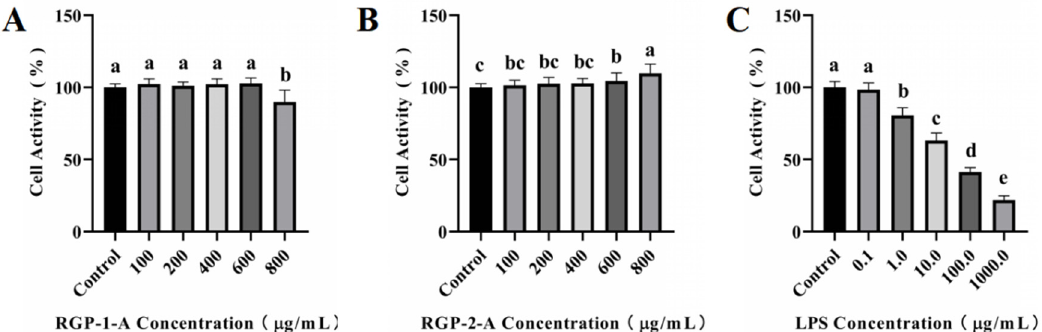
Figure 3. Cytotoxicity assay of RGP-1-A ( A ) and RGP-2-A ( B ) and LPS model establishment ( C ). RGP-1-A: decolorized pure polysaccharide of RGP obtained using AB-8 macroporous resin; RGP-2-A: decolorized pure polysaccharide of RGP obtained using H 2 O 2 . On the bar graphs, different lowercase letters signify a significant difference ( p < 0.05).